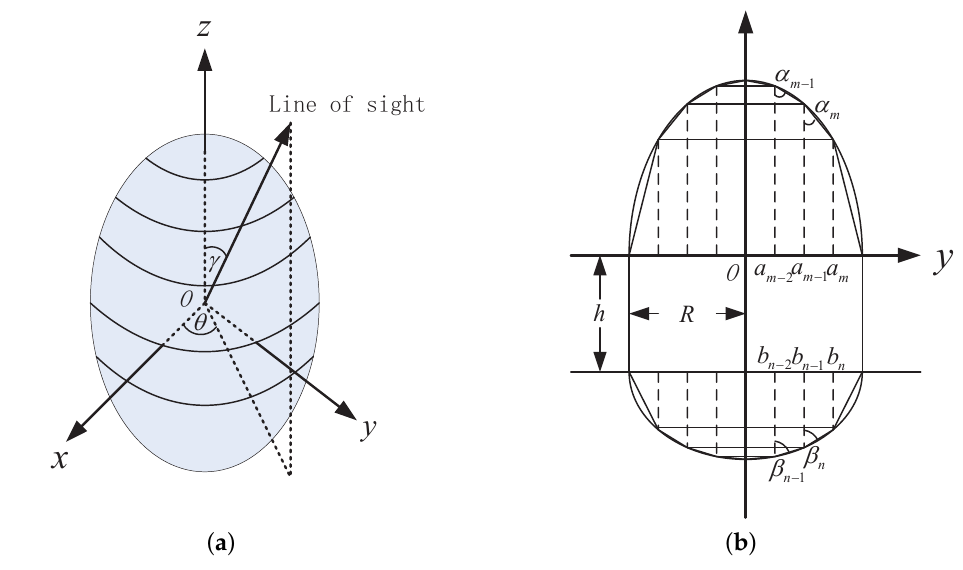
Figure 1. Illustration of the mathematical representation for the projection function. ( a ) shows the projection geometry and the partition of the surface into many rings; and ( b ) shows the approximation of the ring surface with the truncated cone surface in the side